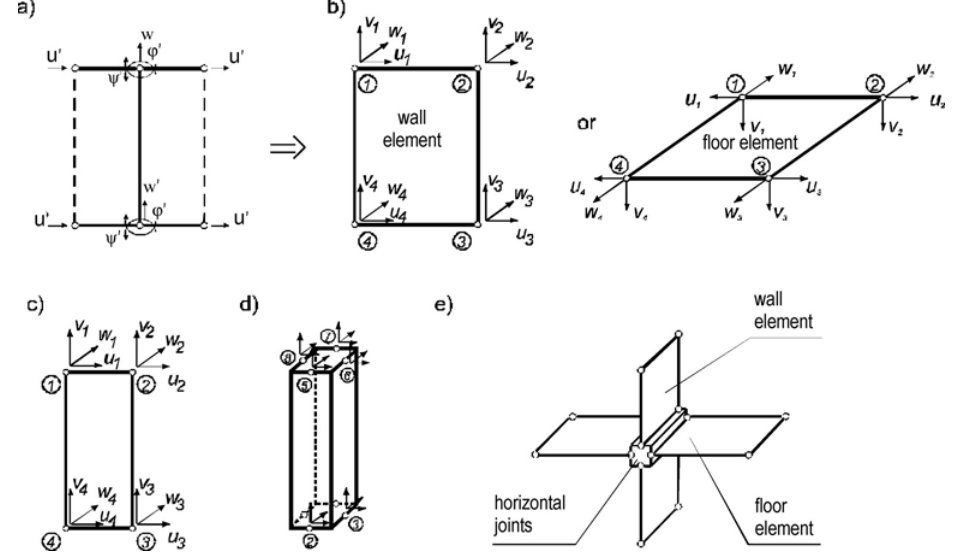
Fig 3 . Elements of the computational model: a) basic wall element, b) wall element with unknowns in the corners, c) plane joint, d) spatial joint, e) wall and floor elements interconnected by three-dimensional